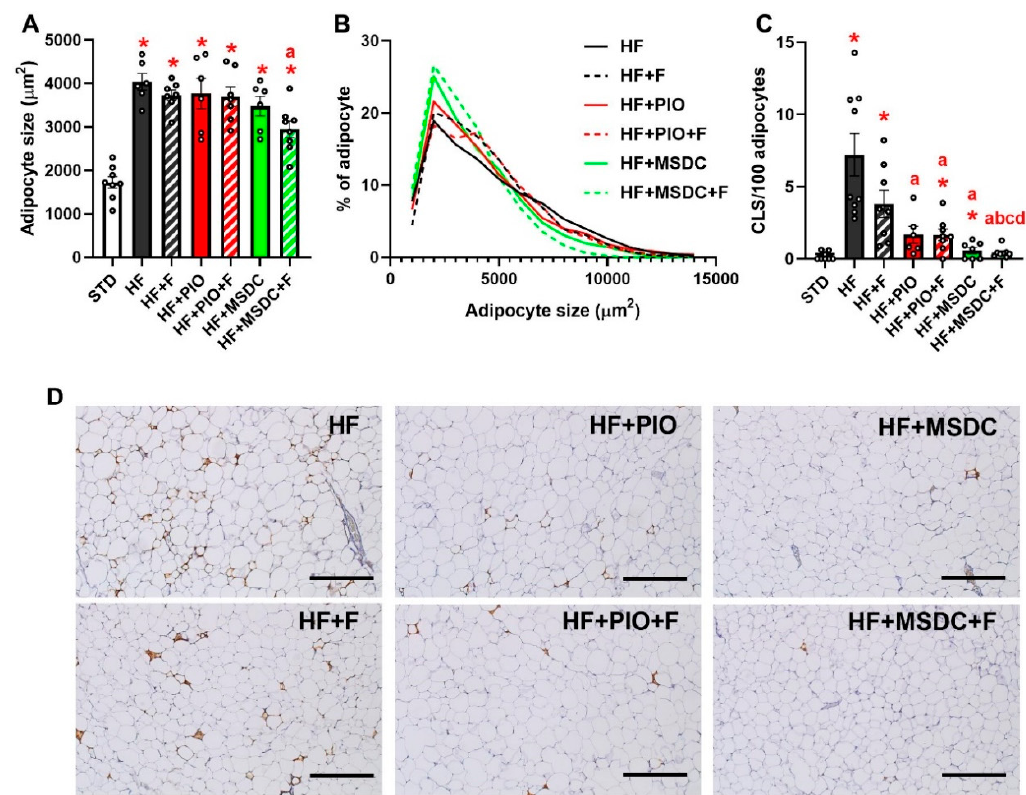
Figure 2. Morphology and immunohistochemistry of epididymal white adipose tissue (eWAT). Mice were fed STD or various HF diets for 8 weeks. Size of eWAT adipocytes was evaluated from hematoxylin + eosin stained sections ( A ) and expressed as mean ( A ) or histogram of adipocyte size (( B ) pooled data from 4800 adipocytes). Inflammation of eWAT was assessed using the anti-Mac-2 antibody, which labeled macrophages aggregated around dying adipocytes (( D ) reddish color; representative histological sections are shown; scale bar = 200 µ m), and was expressed as the percentage of CLS / 100 adipocytes ( C ). Data are means ± SEMs ( n = 8). * Significantly different from STD ( p ≤ 0.05, t -test). a—significantly different vs. HF; b—significantly different vs. HF + F; c—significantly different vs. HF + PIO; d—significantly different vs. HF + PIO + F ( p ≤ 0.05, one-way